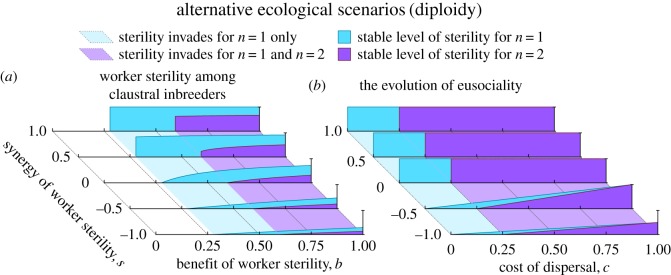
The evolution of worker sterility under alternative ecological scenarios, for diploidy. Here, we determine the stable level of worker sterility under two demographically explicit models of worker sterility; see Methods for full details. (a) For claustral inbreeders under diploidy, monogamy promotes worker sterility relative to promiscuity; we show results for k=4 here. (b) For the evolution of eusociality via non-dispersing female workers under diploidy, monogamy promotes worker sterility relative to promiscuity. Note that while figures 6c and 7a are qualitatively similar but quantitatively different, figures 6d and 7b are identical, highlighting the varying impact of haplodiploidy versus diploidy within alternative ecological scenarios.